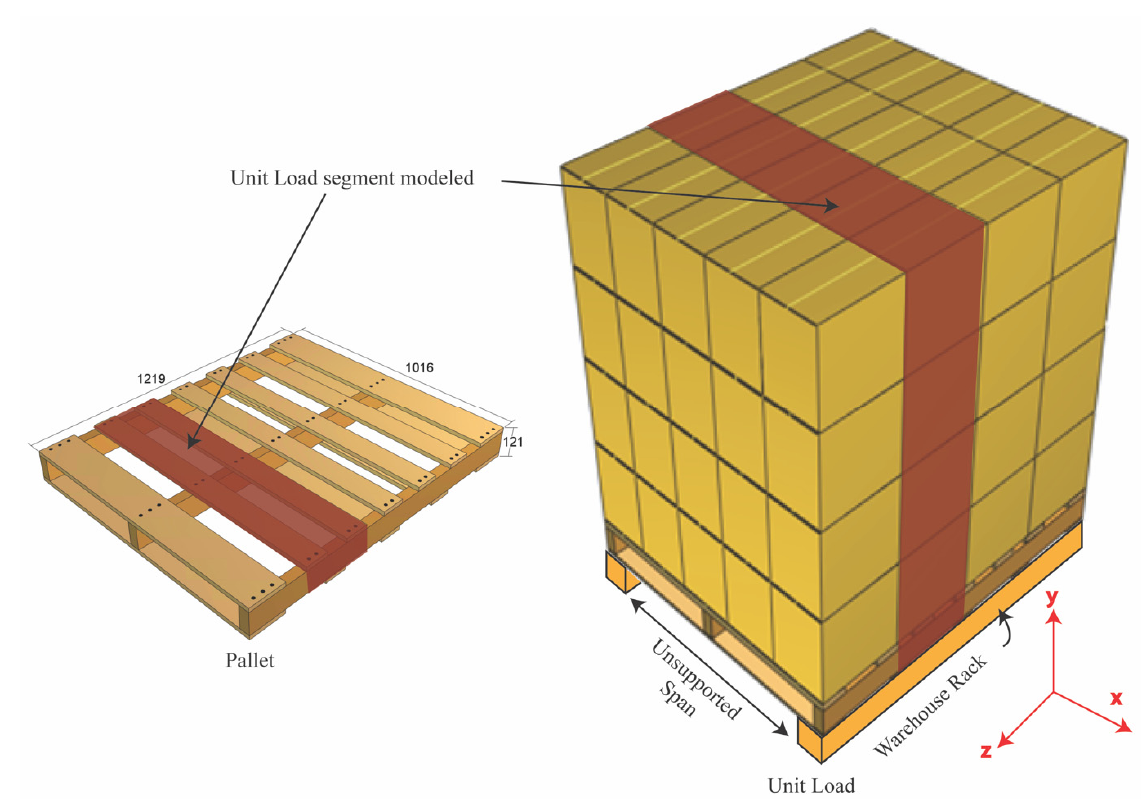
Figure 1. Diagram of a pallet and of a unit load supported on a warehouse rack across the width. Red shaded segment represents the unit load and pallet sections modeled.